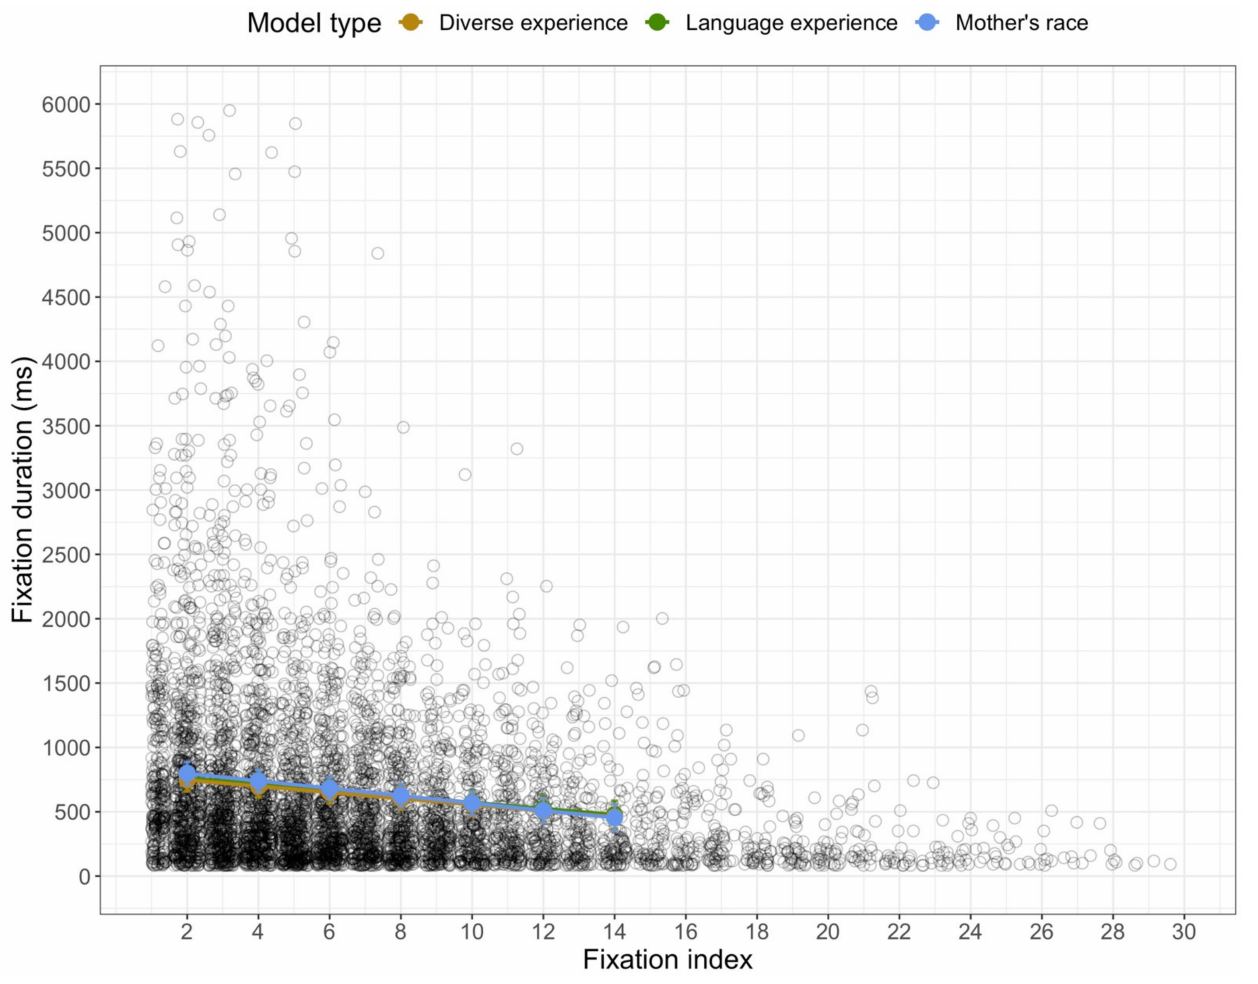
Figure 7. The duration of fixations as a function of fixation index. Each dot represents a single fixation from a single infant; the three lines represent the estimated marginal means from the three models. Note, this figure removed three fixations that had durations greater than 6000 ms (all fixation index <3), but all fixations were included in the model. In addition, as this figure demonstrates, the number of fixations decreased dramatically as the fixation index increased. In fact, 93% of the fixations were index 1 through 14. In future figures, we show model estimates to index 14. Error bars represent 95% Sidak-adjusted confidence